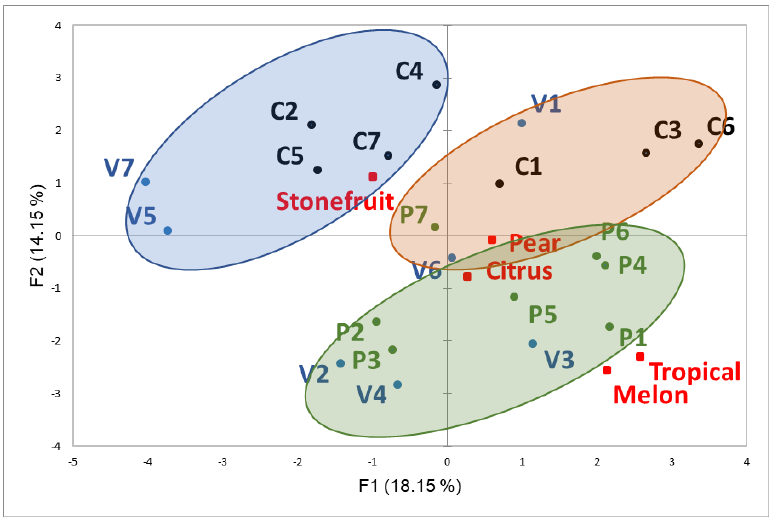
Figure 3. MFA plot showing wine consumers’ PPM results for first and second factors. Ellipses iden- tify groups according to k-means clustering. Varietal wines are shown in different colors.